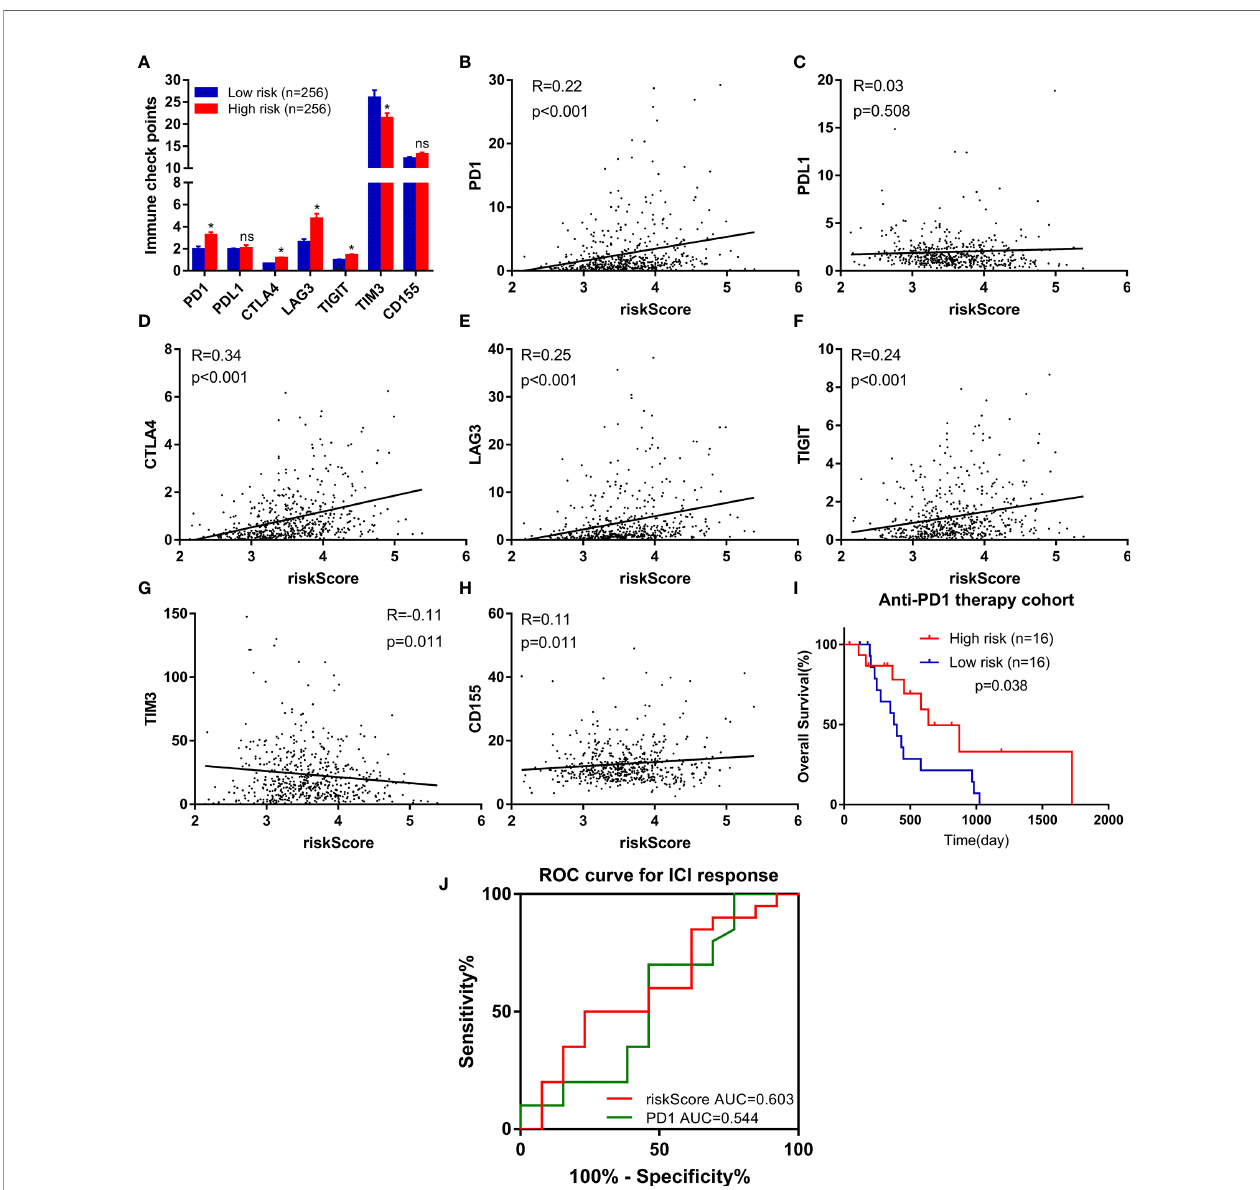
FIGURE 6 | FeSig was a potential indicator of response to anti-PD-1 therapy. (A) The expression level of immune checkpoints between high-risk group and low-risk group. (B – H) The correlation between immune checkpoints and risk score. (I) High risk group of patients with anti-PD-1 monotherapy had better OS. (J) ROC curve of ICI response showed that FeSig had good diagnostic value. OS, overall survival; ROC, receiver operating characteristic; ICI, immune checkpoint inhibitor. *P < 0.05; ns, no signi fi cance.